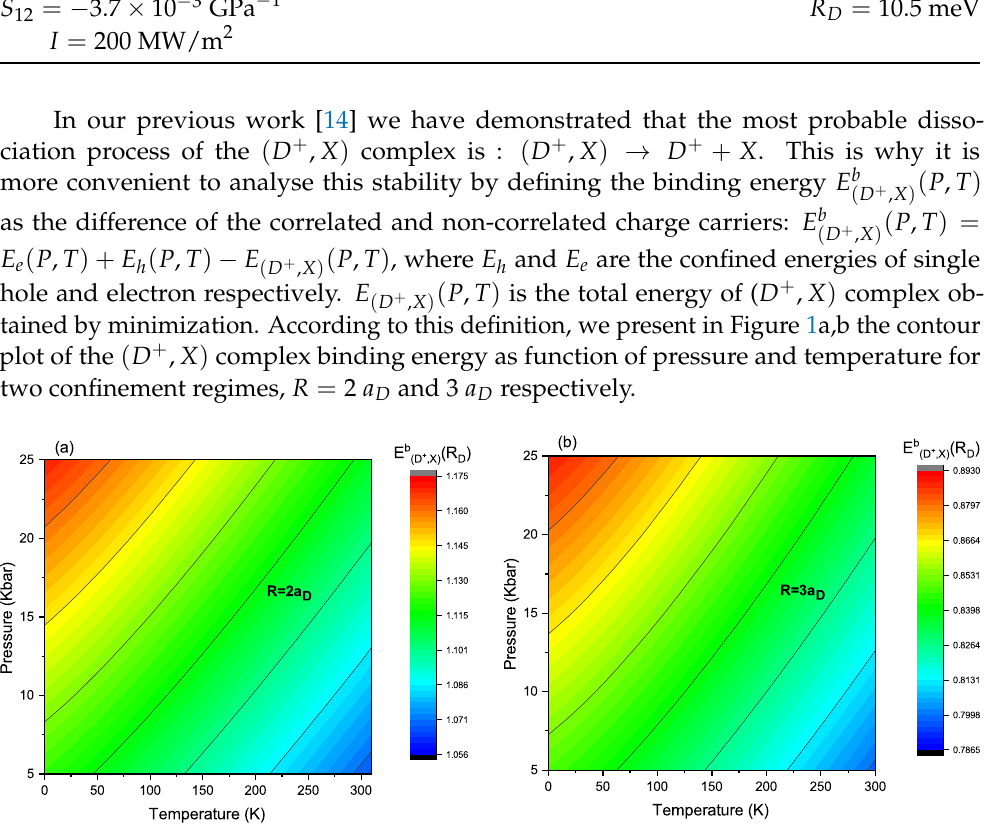
Figure 1. Binding energy variation of an exciton bound to an ionized donor as a function of pressure and temperature for the radius R = 2 a D ( a ) and R = 3 a D ( b